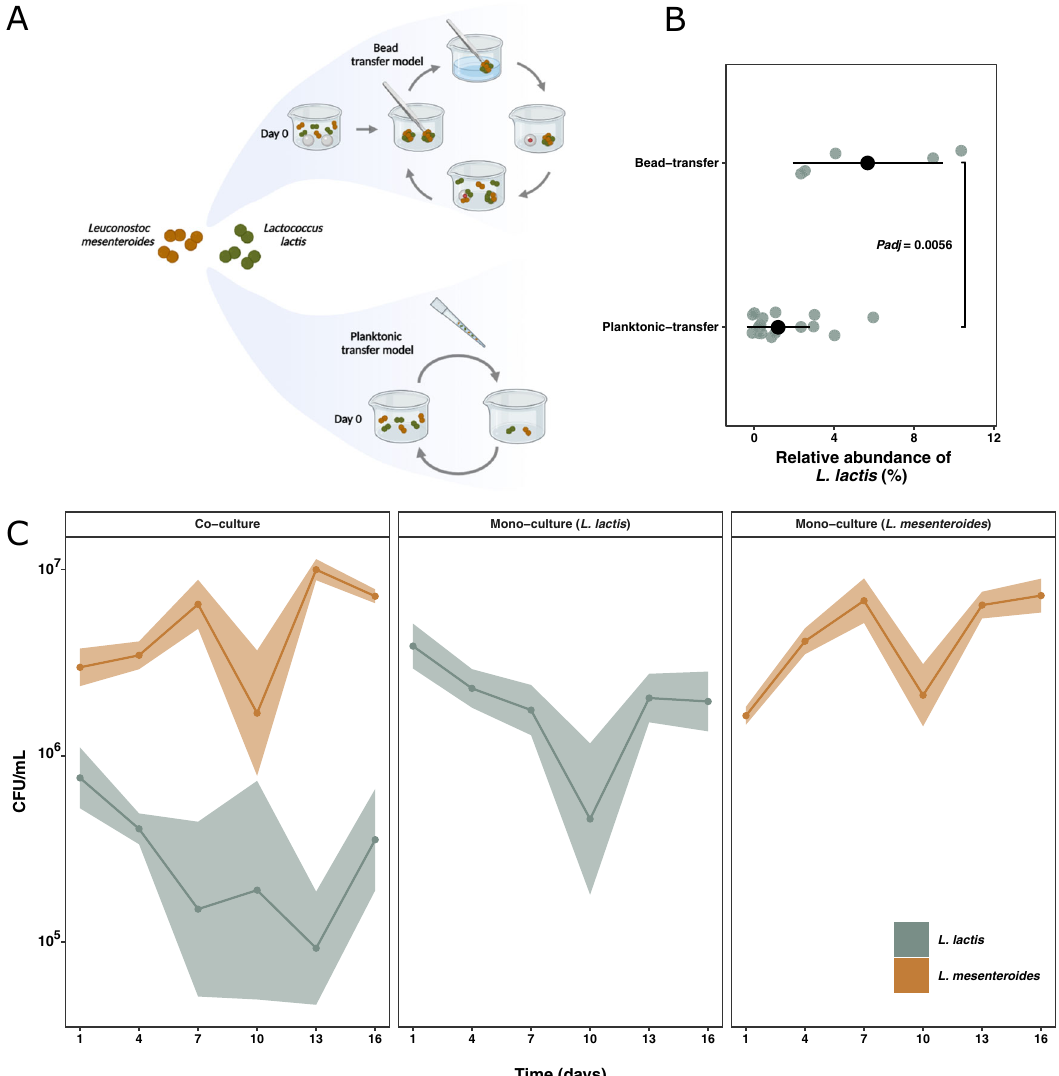
Fig. 1 The modi fi ed bead-transfer model procedure and culture dynamics of Lactococcus lactis and Leuconostoc mesenteroides during 16 days of cultivation. A In the bead transfer model, L. lactis and L. mesenteroides were cultured individually or together on glass beads. After 24 h of cultivation, a bead with attached bio fi lm was washed three times and moved to a new container with labeled glass beads (marked with dots). Bacterial cells were allowed to disperse and attach to the new labeled beads for 24 h before transfer. At every third transfer, a single bead was sonicated to release and disperse bio fi lm cells for CFU quanti fi cation and isolation of evolved strains (Illustration created with Biorender.com). B Relative abundance of L. lactis in co-cultures with L. mesenteroides at day 16 in the bead-transfer model and planktonic- transfer model. The relative abundance of L. lactis was signi fi cantly higher in the bead-transfer model at day 16 compared to planktonic- transfer ( P = 0.0056, Wilcoxon Rank-Sum test). C Cell counts of L. lactis and L. mesenteroides for mono- and co-cultures throughout the duration of the bead transfer experiment. Numbers of L. mesenteroides were unaffected by the co-cultivation ( P > 0.05, Welch Two Sample t test), except for day 1 and 13 ( P = 0.004 for both, Welch Two Sample t test), when comparing mono- and co-culture populations, whereas the number of L. lactis were reduced by co-cultivation compared to mono-cultivation ( P < 0.05, Welch Two Sample t test, except day 10 where P = 0.33). Graph depicts means and 95% con fi dence intervals as solid lines and ribbons, respectively. Five biological replicates (lineages) were included. N =